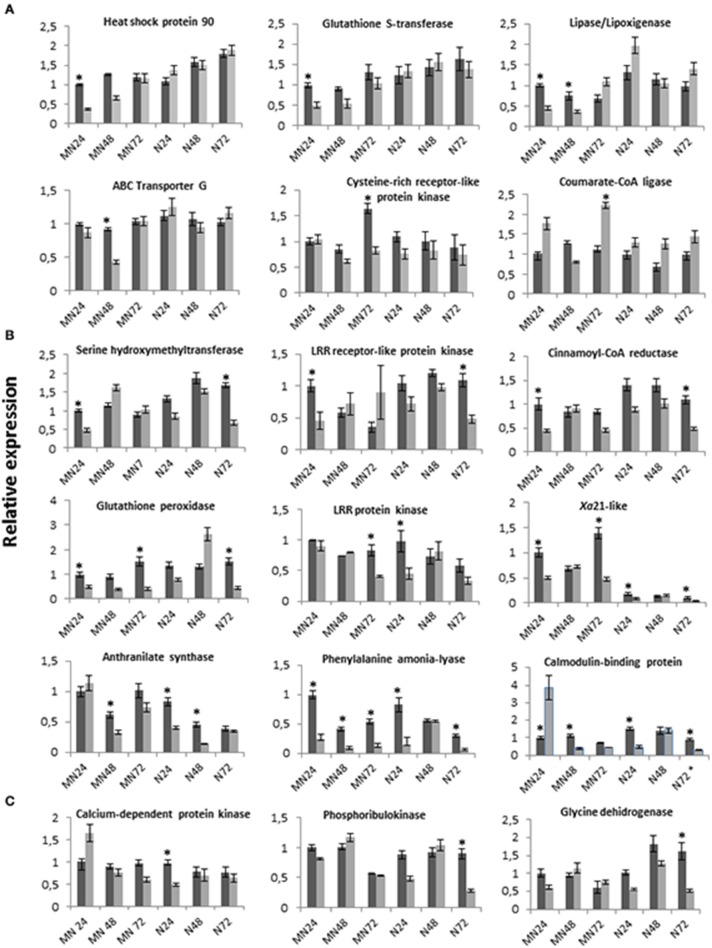
Time-course expression profiles of 18 selected isogroups in the PR genotype MN841801-1 and the susceptible genotype Noble-2 following inoculation with P. coronata (dark boxes), and after mock inoculation (clear boxes). The relative expressions of genes are represented as the mean ± SE for the results of two independent RT-qPCR experiments. Within each diagram data are in relation to the expression level of the sample MN841801-1, 24 hpi after inoculation (relative expression = 1). A gene was considered significantly induced or repressed when the ratio between the inoculated and control plants was >2 or < 0.5, respectively. Significant differences are indicated by an asterisk. (A) Isogroups upregulated in MN841801-1. (B) Isogroups upregulated in MN841801-1 and in Noble-2. (C) Isogroups upregulated in Noble-2.